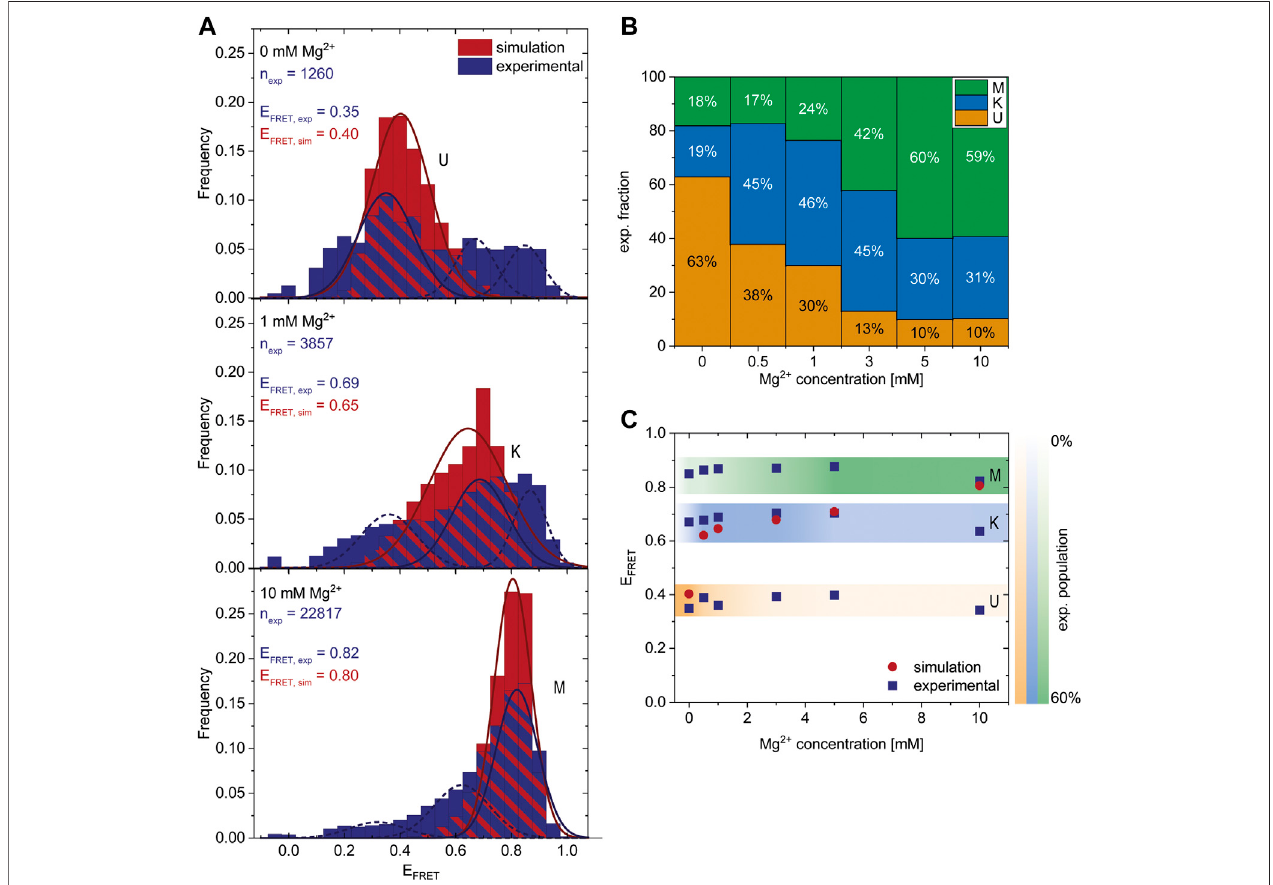
FIGURE 3 | Comparison of experimental smFRET and simulated response of the riboswitch RNA to varying Mg 2+ concentrations. (A) Histograms of the populations obtained in the smFRET experiments (exp) (dark blue) and in the coarse-grained simulations (sim) (red) at different Mg 2+ concentrations. n exp describes the number of molecules represented in the experimental histograms. The experiments were fi tted with three Gaussians corresponding to the three states. The dark blue solidlinerepresentsthemainstateattheconditions,theotherstatesareshownasadashedline.Thesimulationswere fi ttedwith1Gaussian(redline)sinceateach concentration predominantly one state was populated while the probability of the other states was negligibly small. The maximum of the Gaussian fi ts E FRET,exp and E FRET,sim corresponds to the FRET ef fi ciency of the most probable structure of each state and is shown as inset. (B) Experimental fraction of riboswitches in the three states at various Mg 2+ concentrations. The fractions were calculated from the area under the fi ts (shown in A ). (C) Comparison of most probable FRET ef fi ciency E FRET (corresponding to the maxima in the Gaussian fi ts shown in A ) from experiments and simulations at various Mg 2+ concentrations.